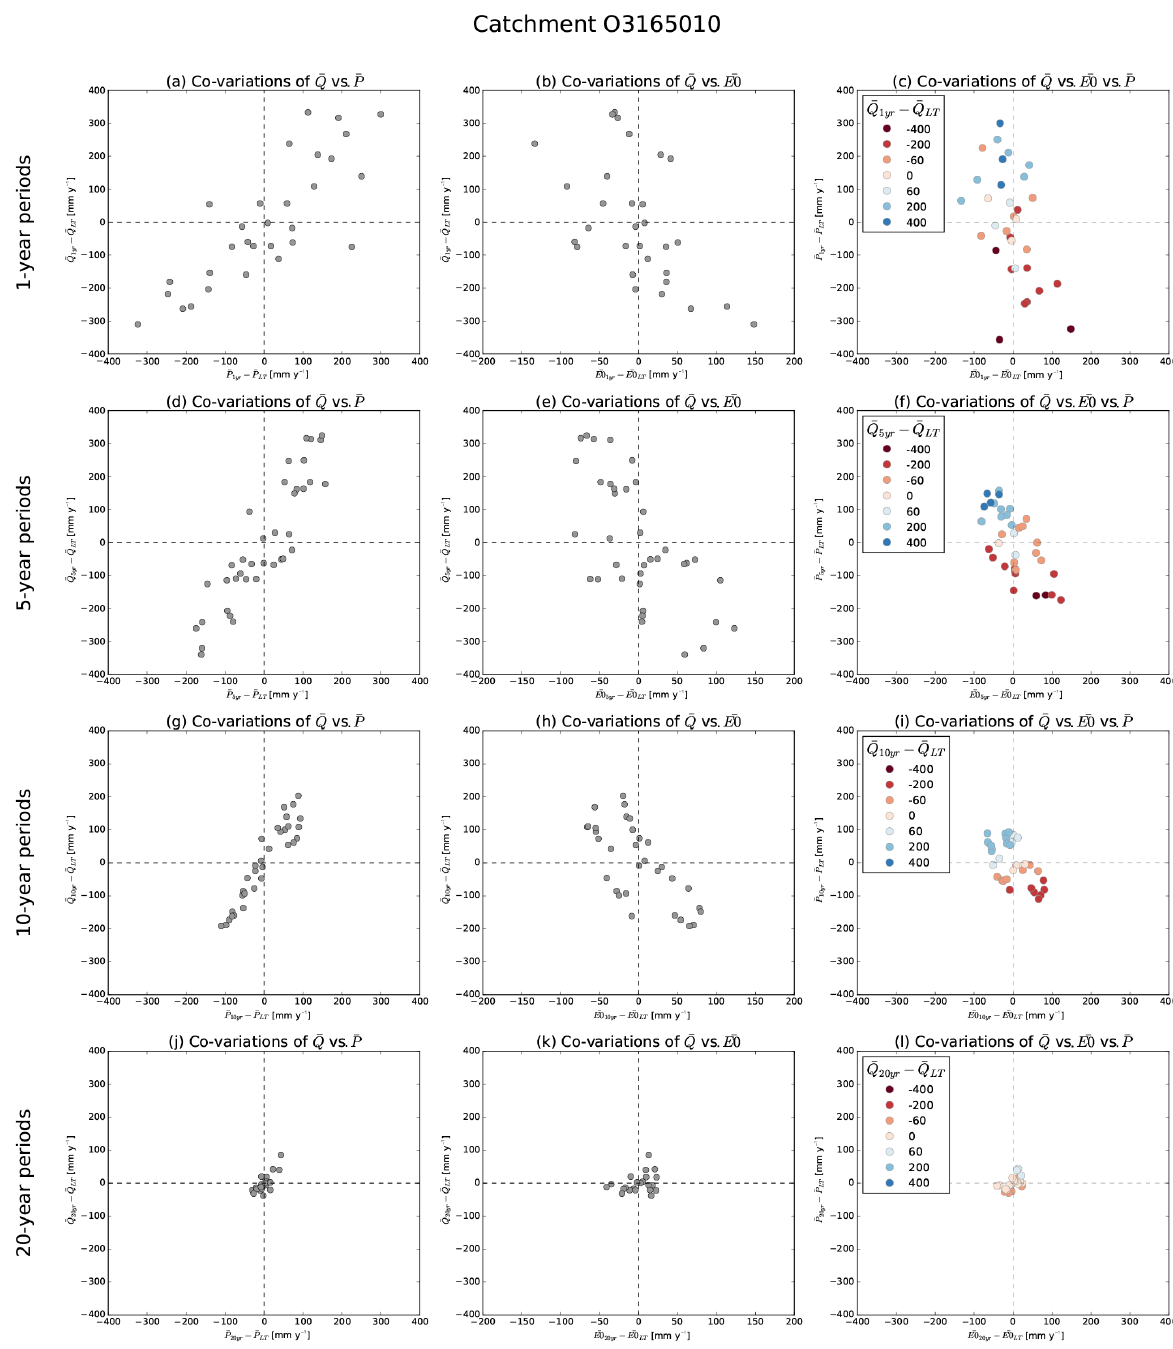
Figure 5. Impact of period length on the streamflow elasticity graphs for an empirical (data-based) assessment. The graphs present from left to right (cid:49)Q vs. (cid:49)P , (cid:49)Q vs. (cid:49)E P , and (cid:49)Q (in colors) vs. (cid:49)P and (cid:49)E P . LT stands for long term (entire